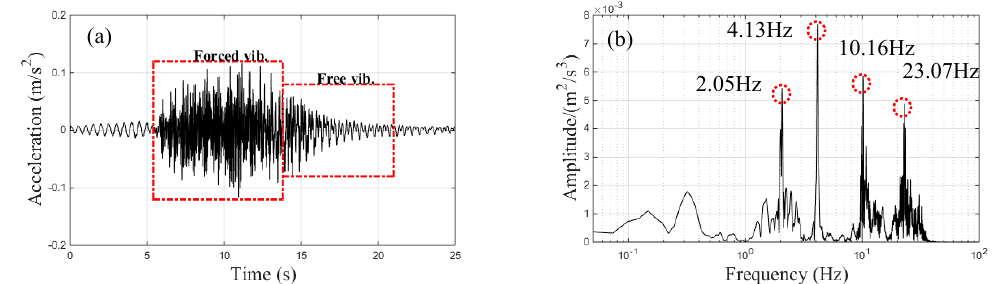
Figure 4. Vertical acceleration signals of the center-point of the main span under a train speed of 120 km / h: ( a ) resampled data; ( b ) fast Fourier transform (FFT) analysis results.